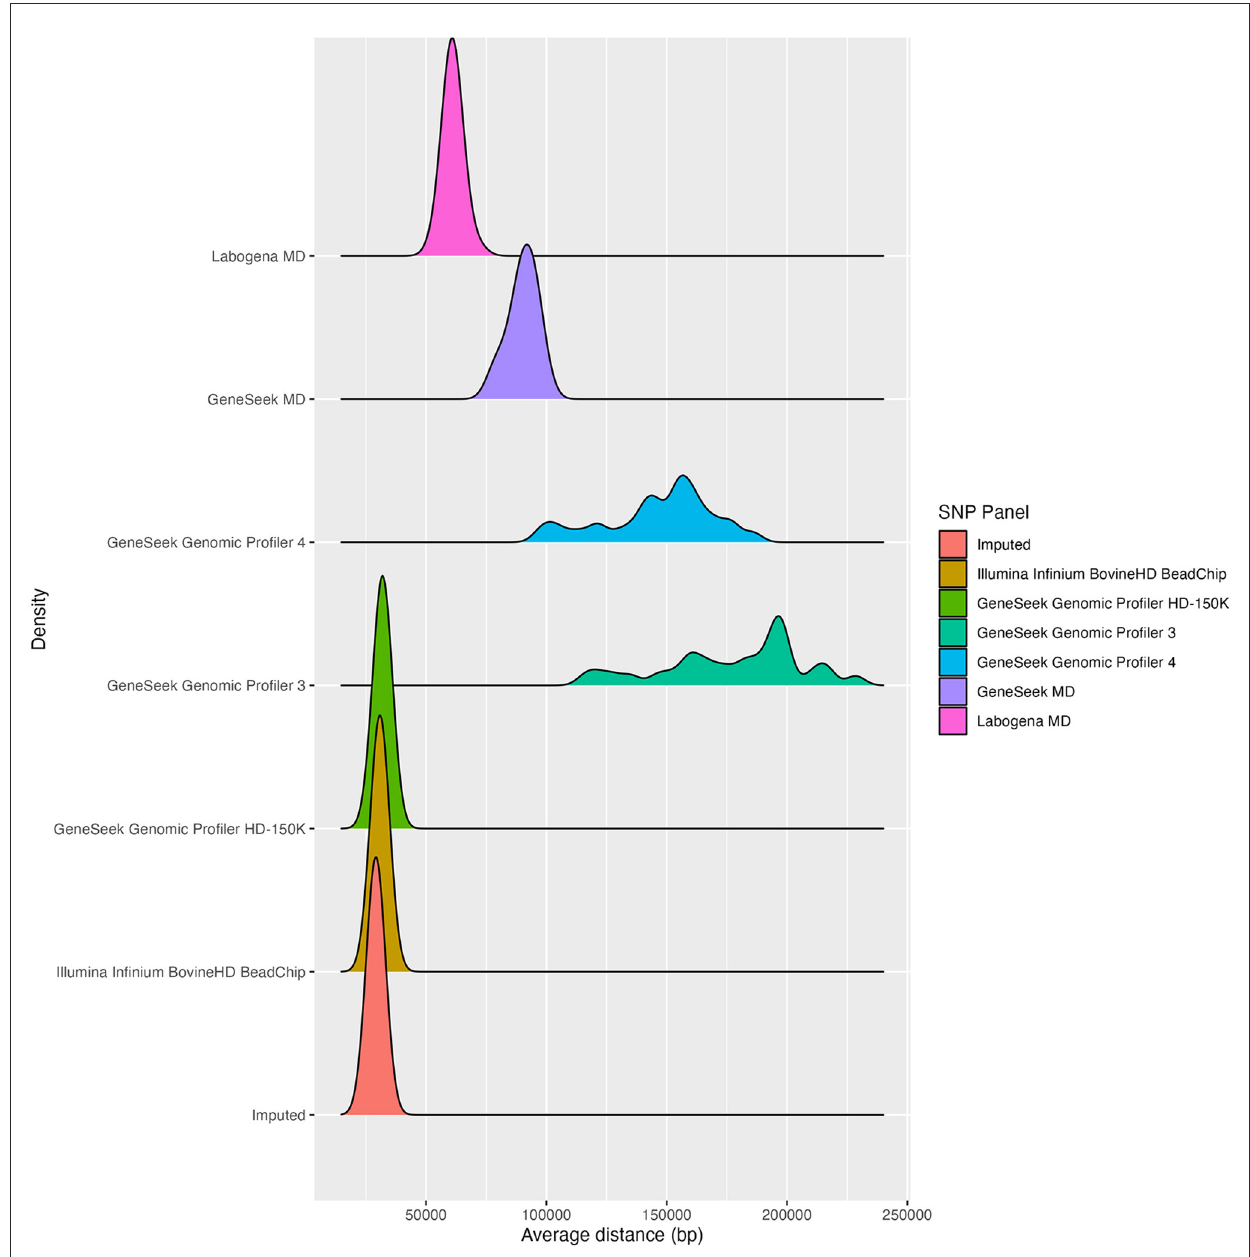
FIGURE2 SNP distance distribution over the 29 autosomes for each of the SNP